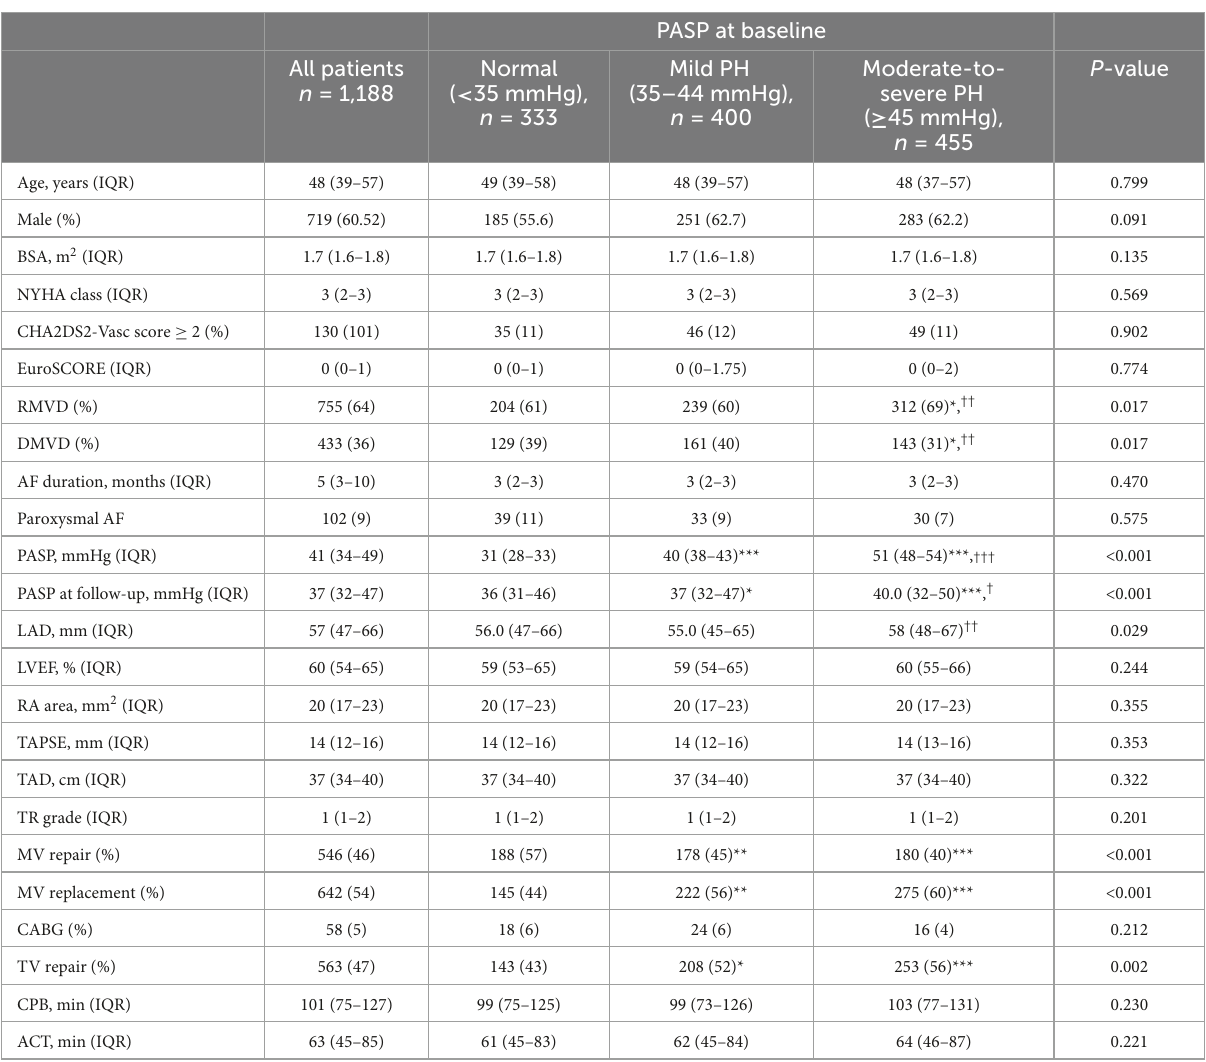
TABLE 1 Baseline characteristics of